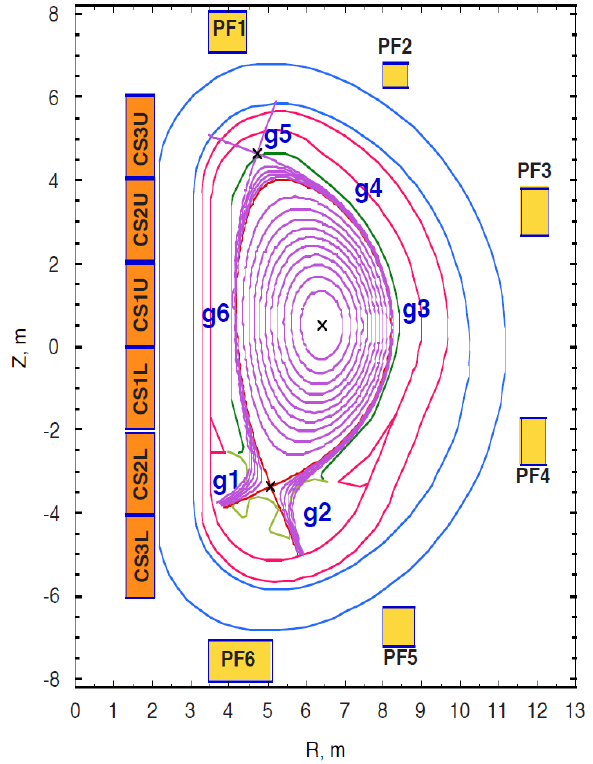
Figure 7. ITER nominal plasma configuration. The upper and lower “×” points are on different magnetic surfaces, defining two separatrixes , the primary one within the secondary one. The g1, g2, …, g6 refer to gaps whose sizes are control variables for plasma stability. The six poloidal field coils that are used to shape the plasma are depicted as PF1, PF2, …, PF6 (from ITER Technical Basis [4]). ©2002 IAEA.